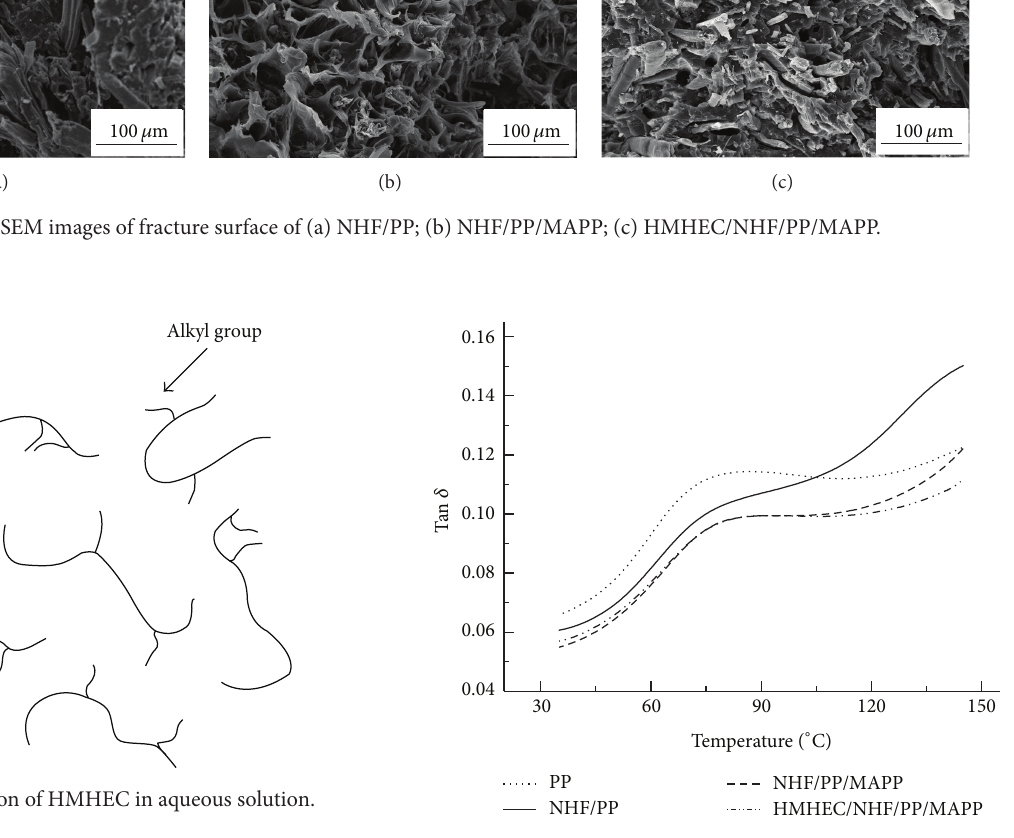
Figure 6: Plots of tan 𝛿 versus temperature of neat PP and its composites.